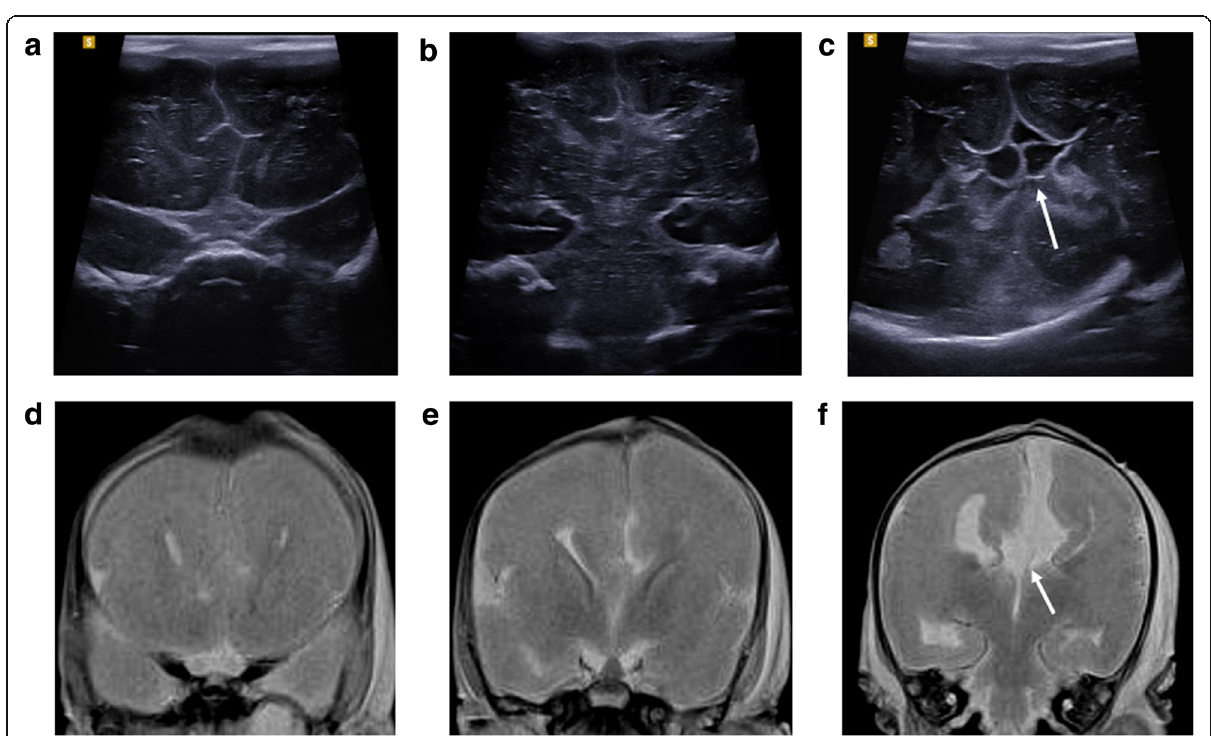
Fig. 4 Post-mortem ultrasound images of the brain, in coronal section (top row), with matched T2-weighted post-mortem MRI images (bottom row) in a foetus at 25weeks gestation. The pregnancy was terminated for suspected brain anomalies. Both imaging modalities were performed 2days after delivery. The images demonstrate views through the frontal lobes ( a , d ), at the level of the Foramen of Monroe ( b , e ) and through the posterior horns of the lateral ventricles ( c , f ). The ultrasound image clearly depicts an interhemispheric cyst (white arrow) with internal septations ( c ), and there is absence of the corpus callosum. This is also evident from the MRI image ( f ), although the cyst is much better viewed on